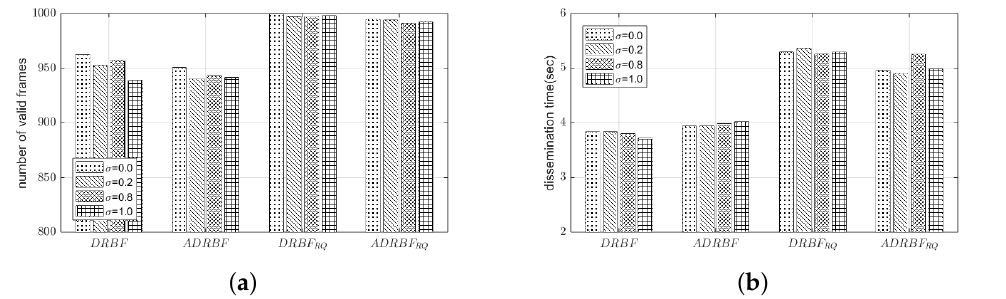
Figure 15. The performance comparison of the proposed flooding mechanisms under the moving scenario: ( a ) the number of valid frames F val and ( b ) the dissemination time T dis .